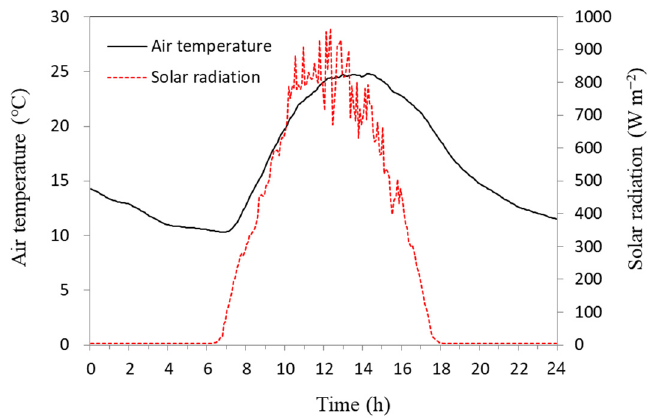
Figure 2. Variations in outside temperature and solar radiation over time (12 − 13, 19 − 20, and 26 − 27 October 2019).